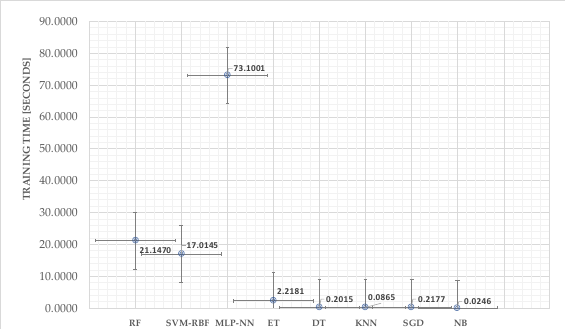
Figure 12. Training time of the eight ML models evaluated in this